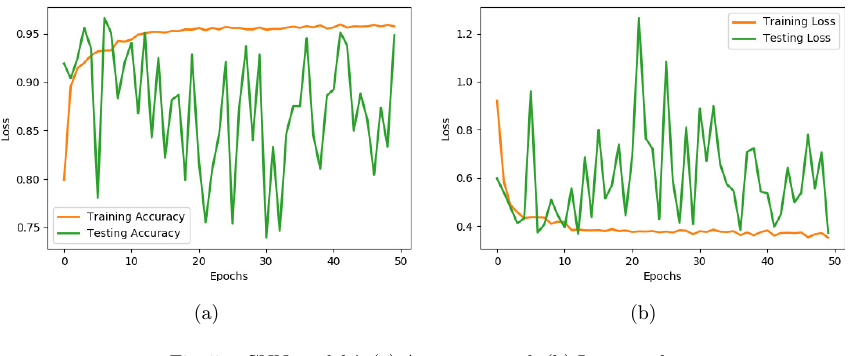
Fig. 5. CNN models': (a) Accuracy graph (b) Loss